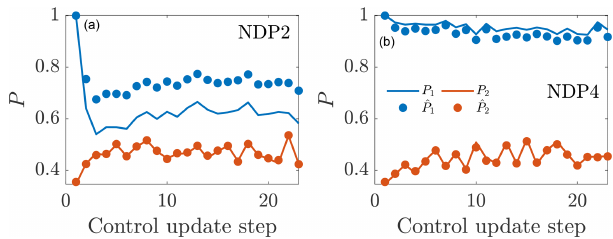
Figure 17. Time-averaged wind farm power production as a func- tion of the control update step for online control using the initial parameters to initialize the next state and (a) ˆ P p = 2 (NDP2) and (b) ˆ P p = 4 (NDP4). The wind farm power is normalized by the power production of the aligned wind farm case.